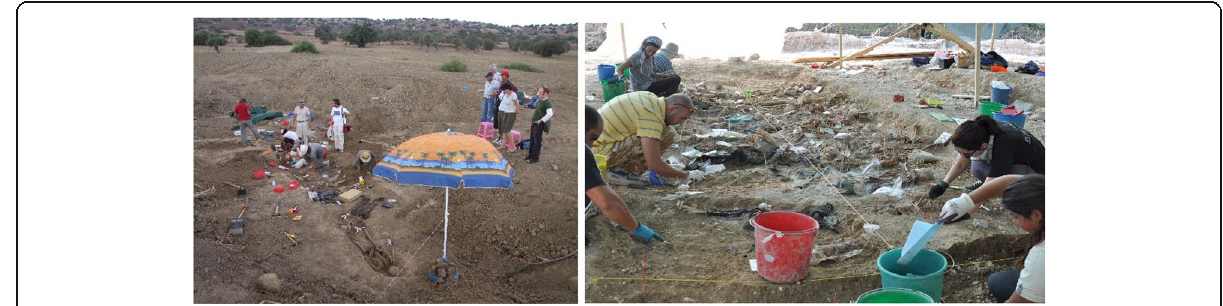
Fig. 1 A mass grave exhumation under the coordination of EAAF in 2008 (left) and a mass grave exhumation in 2016 performed exclusively by the CMP archaeologists